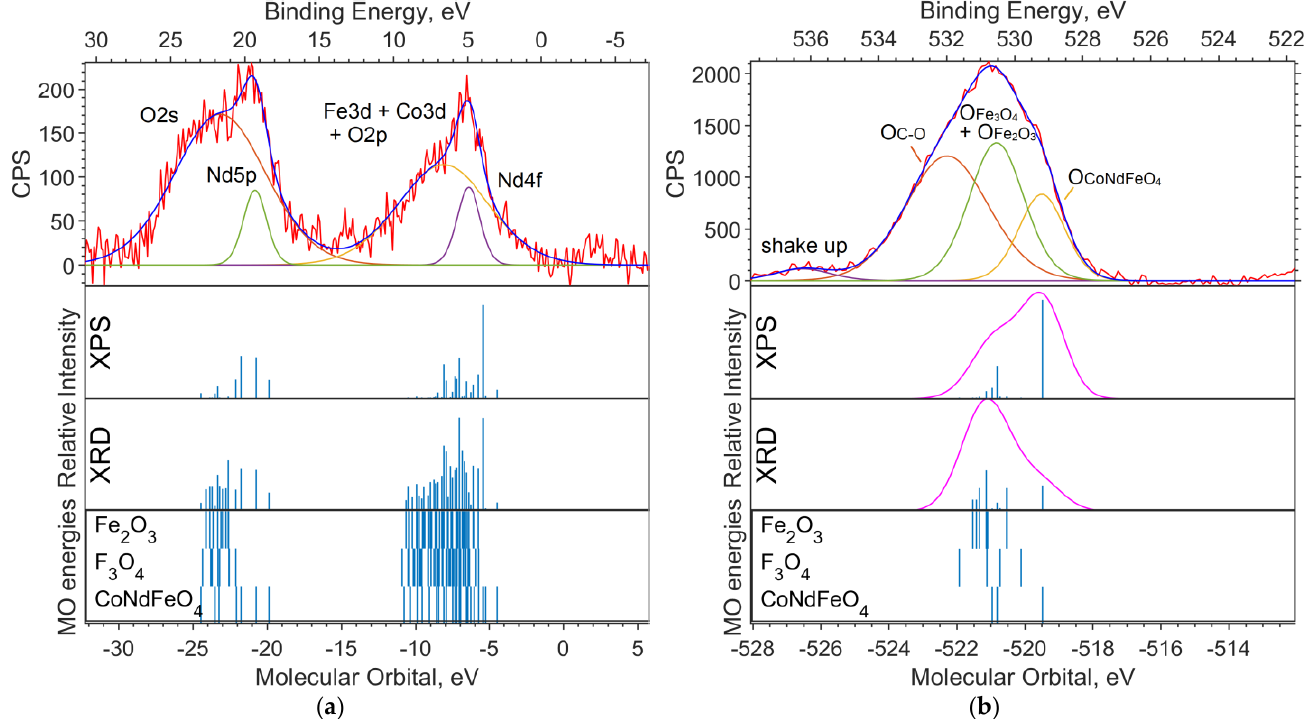
Figure 5. ( a ) XPS spectrum of the valence region and ( b ) spectrum of oxygen 1s levels for the NdFe (1 − x) Co x B oxide powders with x = 0.05. The theoretical spectral intensities based on XPS (top) and XRD (bottom) concentrations, and the MO energies of the model compounds with Gaussian functions with a half-width FWMH = 1.5 eV are superimposed on the theoretical intensities on ( b ).